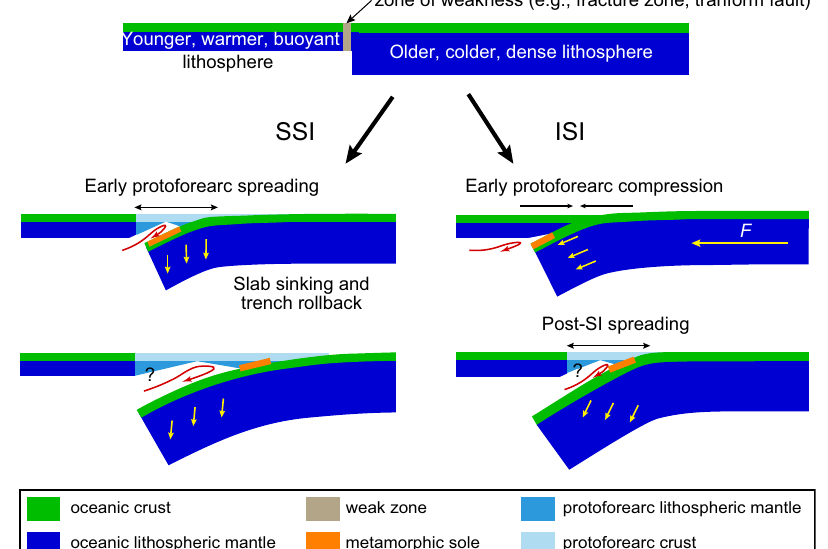
Fig. 1 Spontaneous subduction initiation and induced subduction initiation in an intra-oceanic setting. The schematic diagram highlights the difference in the relative timing of the formation of metamorphic sole and proto-forearc spreading in the two modes (modi fi ed from refs. 15,20,85